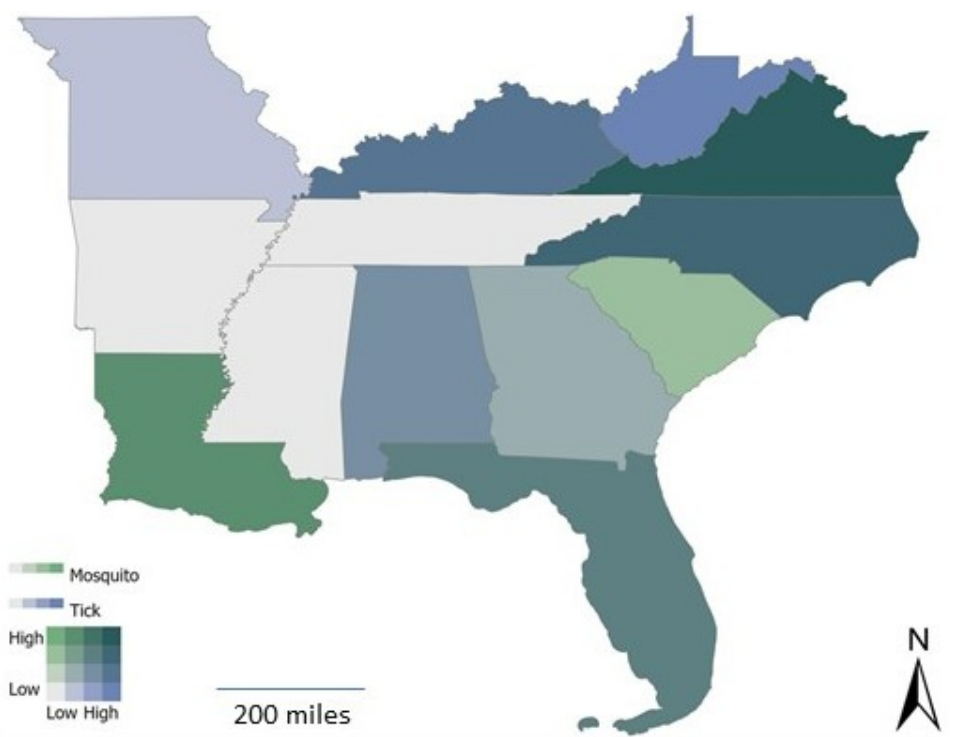
Figure 2. Reported number of mosquito species versus number of tick species reported in each state.